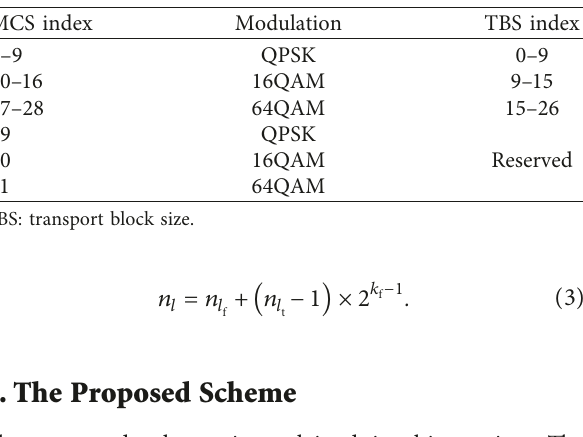
Figure 2: An LTE PHY frame structure. Table 1: Relation between MCS index, modulation, and TBS